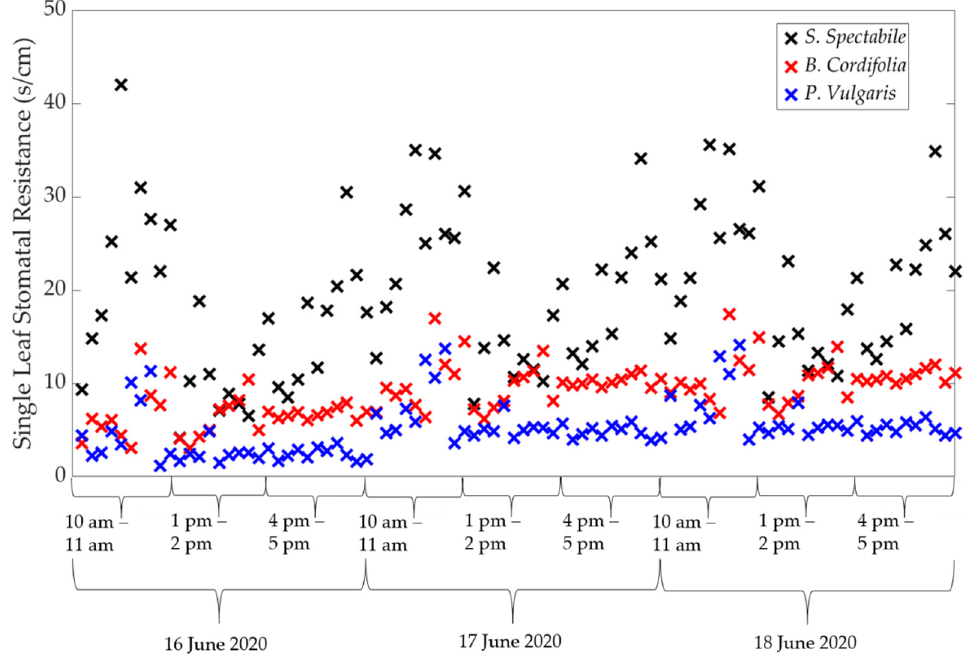
Figure 2. Leaf stomatal resistance values from the S. spectabile , B. cordfolia and P. vulgaris species between 16 and 18 June 2020.